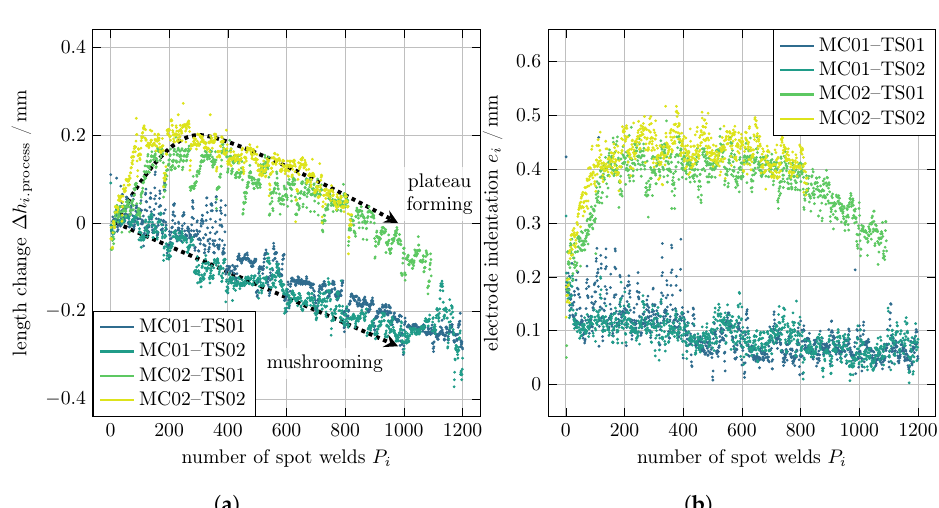
Figure 18. ( a ) Different behaviors in length change ∆ h i .process of upper or lower electrodes form MC01 and MC02 as a result of two different wear modes, mushrooming and plateau forming. ( b ) Calculated electrode indentation e i from displacement measurements.